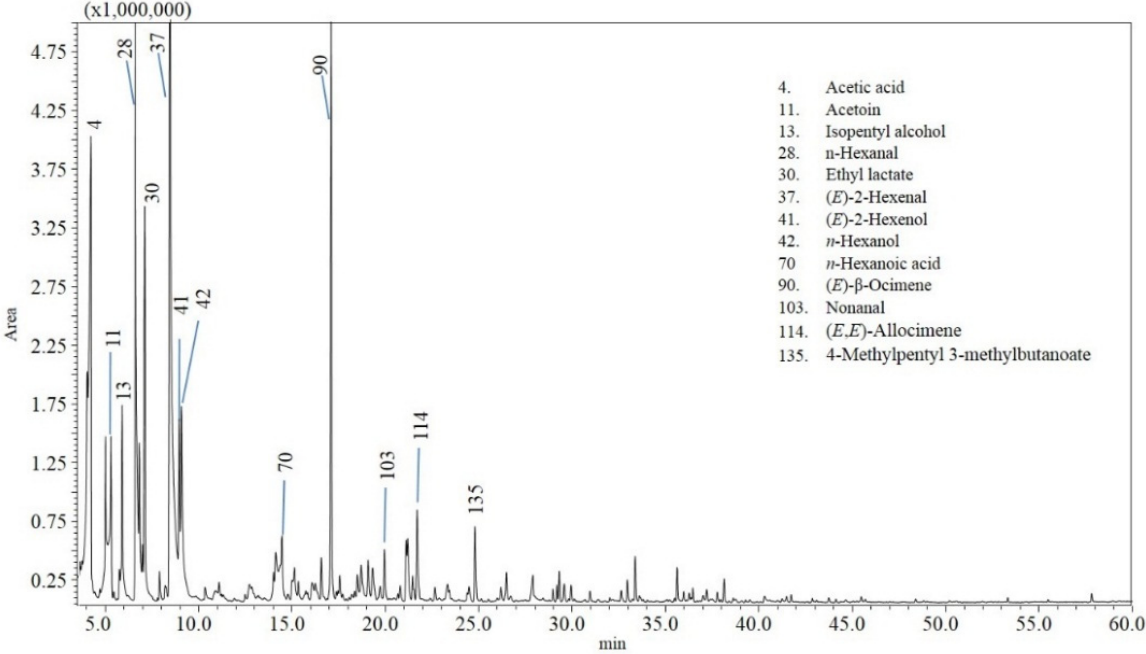
Figure 3. GC ‐ MS analysis of the volatile profile for sample 17 ( C. baccatum —Aji).